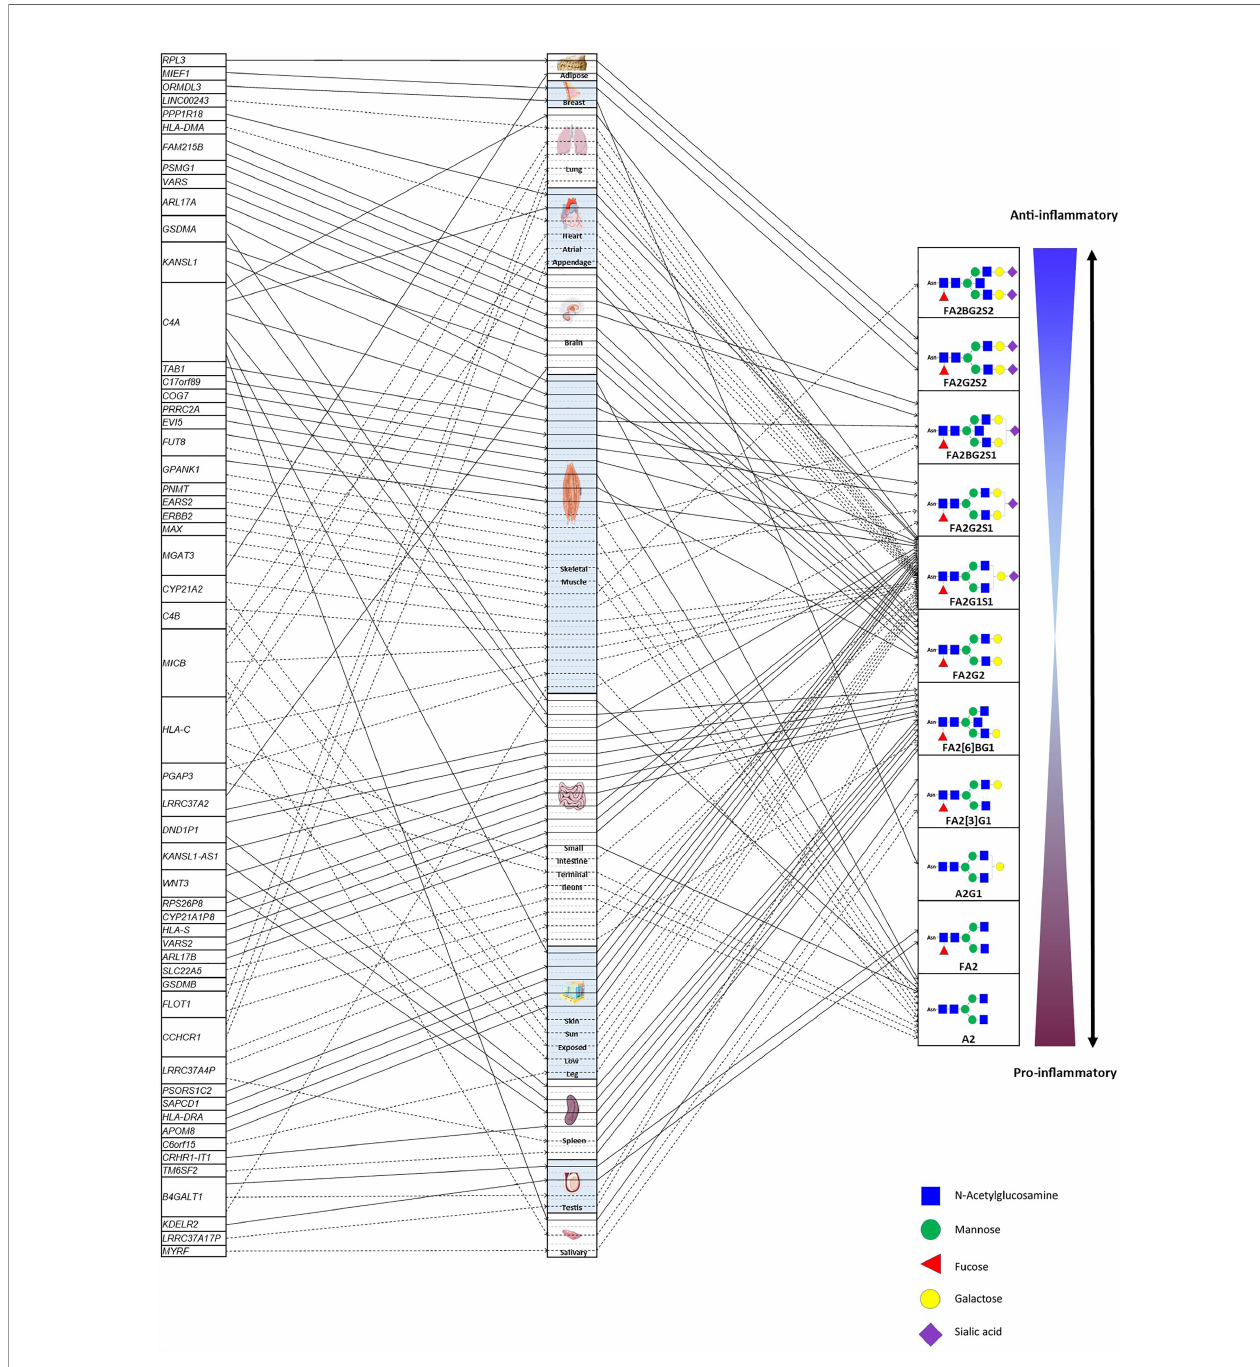
FIGURE 4 | The atlas of TWAS statistically signi fi cant genes regulating IgG N-glycosylation within speci fi c tissues. The left column lists the candidate genes of IgG N-glycosylation. The middle column comprises the tissues enriched to the candidate genes of IgG N-glycosylation. The various types of brain tissue from the GETx consortium (v7) were allocated to the “ brain ” tissue group to reduce FDR. The right column indicates the IgG N-glycosylation traits associated with candidate genes within relevant tissues. F, core (if the fi rst letter) or antennary fucose; A2, biantennary; B, bisecting N-acetylglucosamine; Gx, galactose; Sx, sialic acid; x, number of galactoses or sialic acids in a glycan structure. Detailed naming and compositional information of GPs was given in previous reports (9, 20) and is listed in Supplementary Table 1 . The solid lines with arrows show the positive effects of the expression of candidate genes on the speci fi c IgG N-glycosylation trait, whereas the dotted lines with arrows show negative